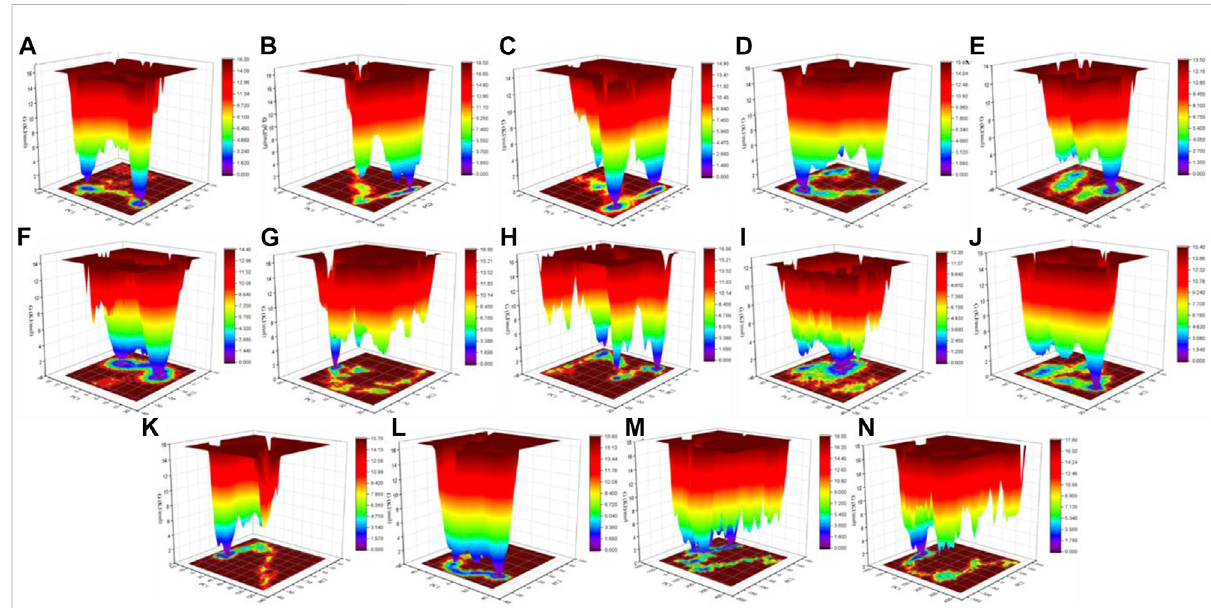
Gibbsenergylandscape.TheGibbsenergylandscapeplotobtainedduring100 nsMDsimulationsfor (A) CTD, (B) CTD-remdesivir, (C) Eprotein, (D) Eprotein-remdesivir, (E) Mprotease, (F) Mprotease-remdesivir, (G) Mprotein, (H) Mprotein-remdesivir, (I) NTD, (J) NTD-remdesivir, (K) RDRP, (L) RDRP-remdesivir, (M) Sprotein, and (N) Sprotein-remdesivir,